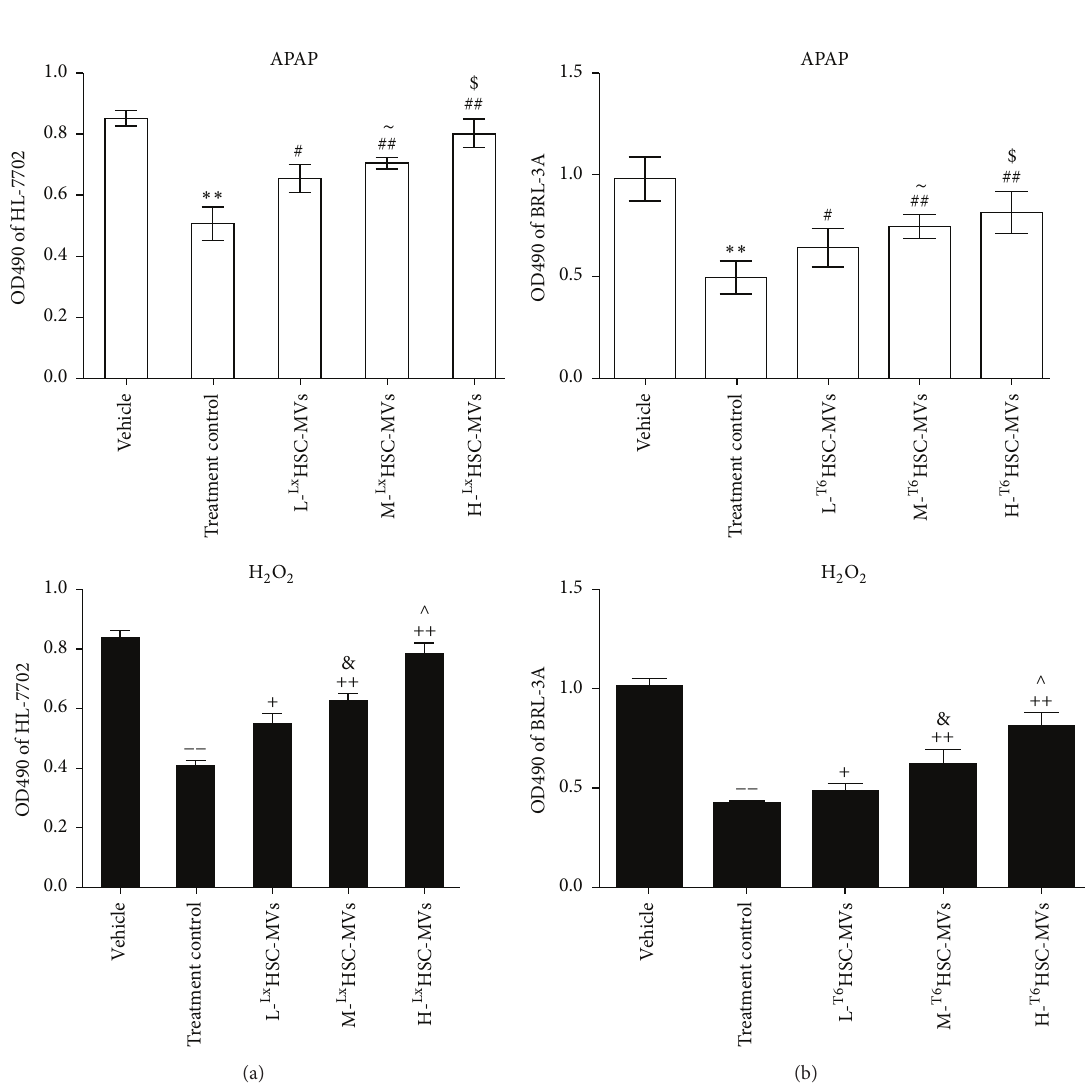
Figure 2: HSC-MVs increased the proliferation of HL-7702 and BRL-3A. (a) Proliferation of APAP or H 2 O 2 -treated BRL-3A cocultured with T6 HSC-MVs. (b) Proliferation of APAP or H Lx HSC-MVs. ∗∗ 𝑝 < 0.01 versus vehicle, APAP; −− 𝑝 < 0.01 2 O 2 -treated HL-7702 cocultured with refers to M-HSC-MVs versus vehicle, H 2 O 2 ; # 𝑝 < 0.05 , ## 𝑝 < 0.01 versus treatment control, APAP; + 𝑝 < 0.05 , ++ 𝑝 < 0.01 versus positive control, H 2 O 2 ; ∼ 𝑝 < 0.01 refers to M-HSC-MVs versus L-HSC-MVs, APAP; & 𝑝 < 0.05 refers to M-HSC-MVs versus L-HSC-MVs, H 2 O 2 ; 𝑛 = 3 /group; ∼ represents 𝑝 < 0.05 versus L-HSC-MVs, APAP; $ 𝑝 < 0.05 versus M-HSC-MVs, APAP; ∧ 𝑝 < 0.05 versus M-HSC-MVs, H 2 O 2 ; & represents 𝑝 < 0.05 versus L-HSC-MVs, H 2 O 2